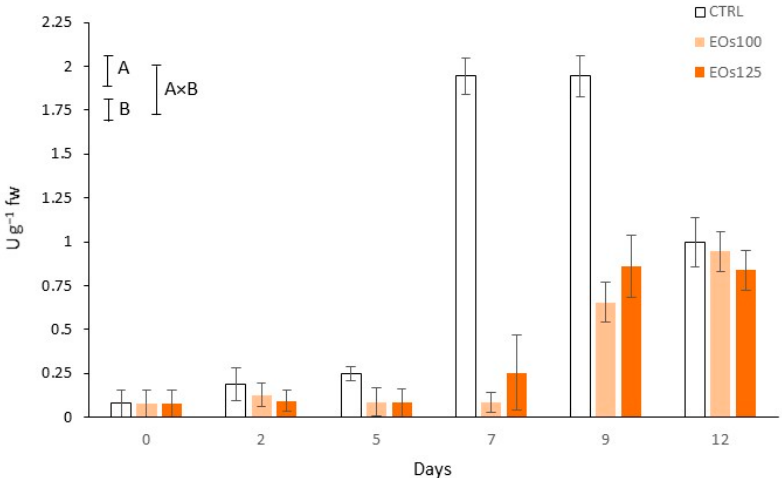
Figure 1. Polyphenoloxidase activity of sliced mushroom during cold storage (4 ◦ C) under modified atmosphere packaging supplemented with vapour essential oils (100 and 125 µ L L − 1 EOs) (mean ± standard deviation). Least significant differences are represented as bars, with A and B letters for the treatment and storage time factors, respectively.